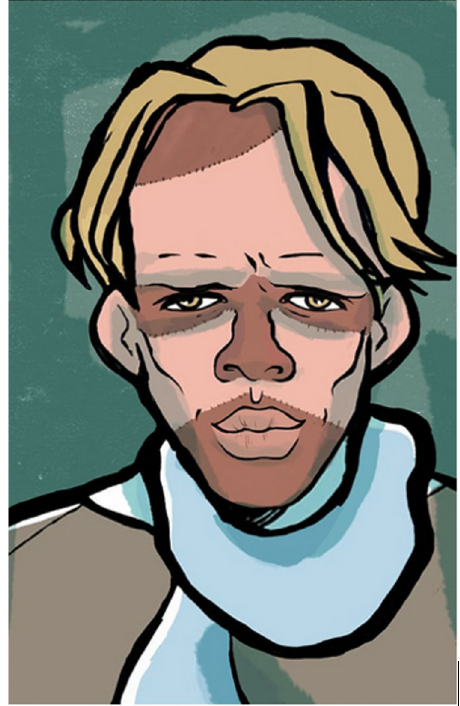
Figure 6: A Picture of